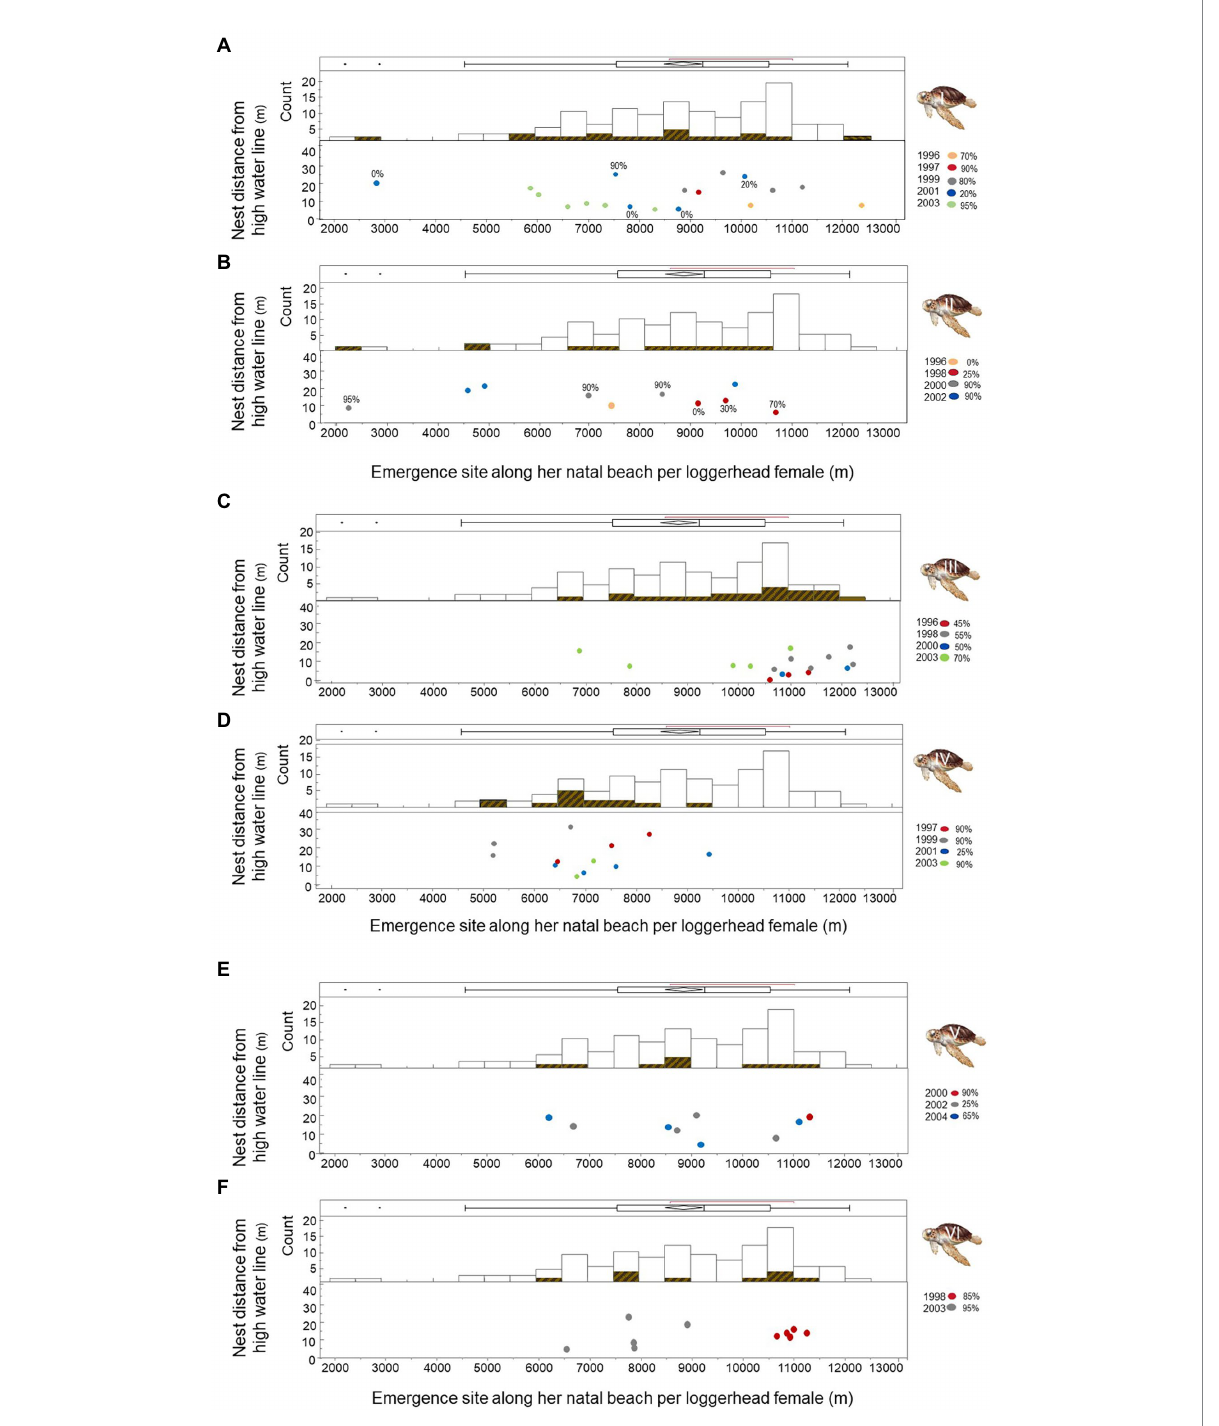
FIGURE 7 Nest site choice on Keewaydin Island by six loggerhead females during multiple breeding seasons from 1996 through 2004. Histograms represent the location of nest sites by each female relative to the combined nest site choices by the group of females. Dots show the years and location of nest sites for each female (A-F)